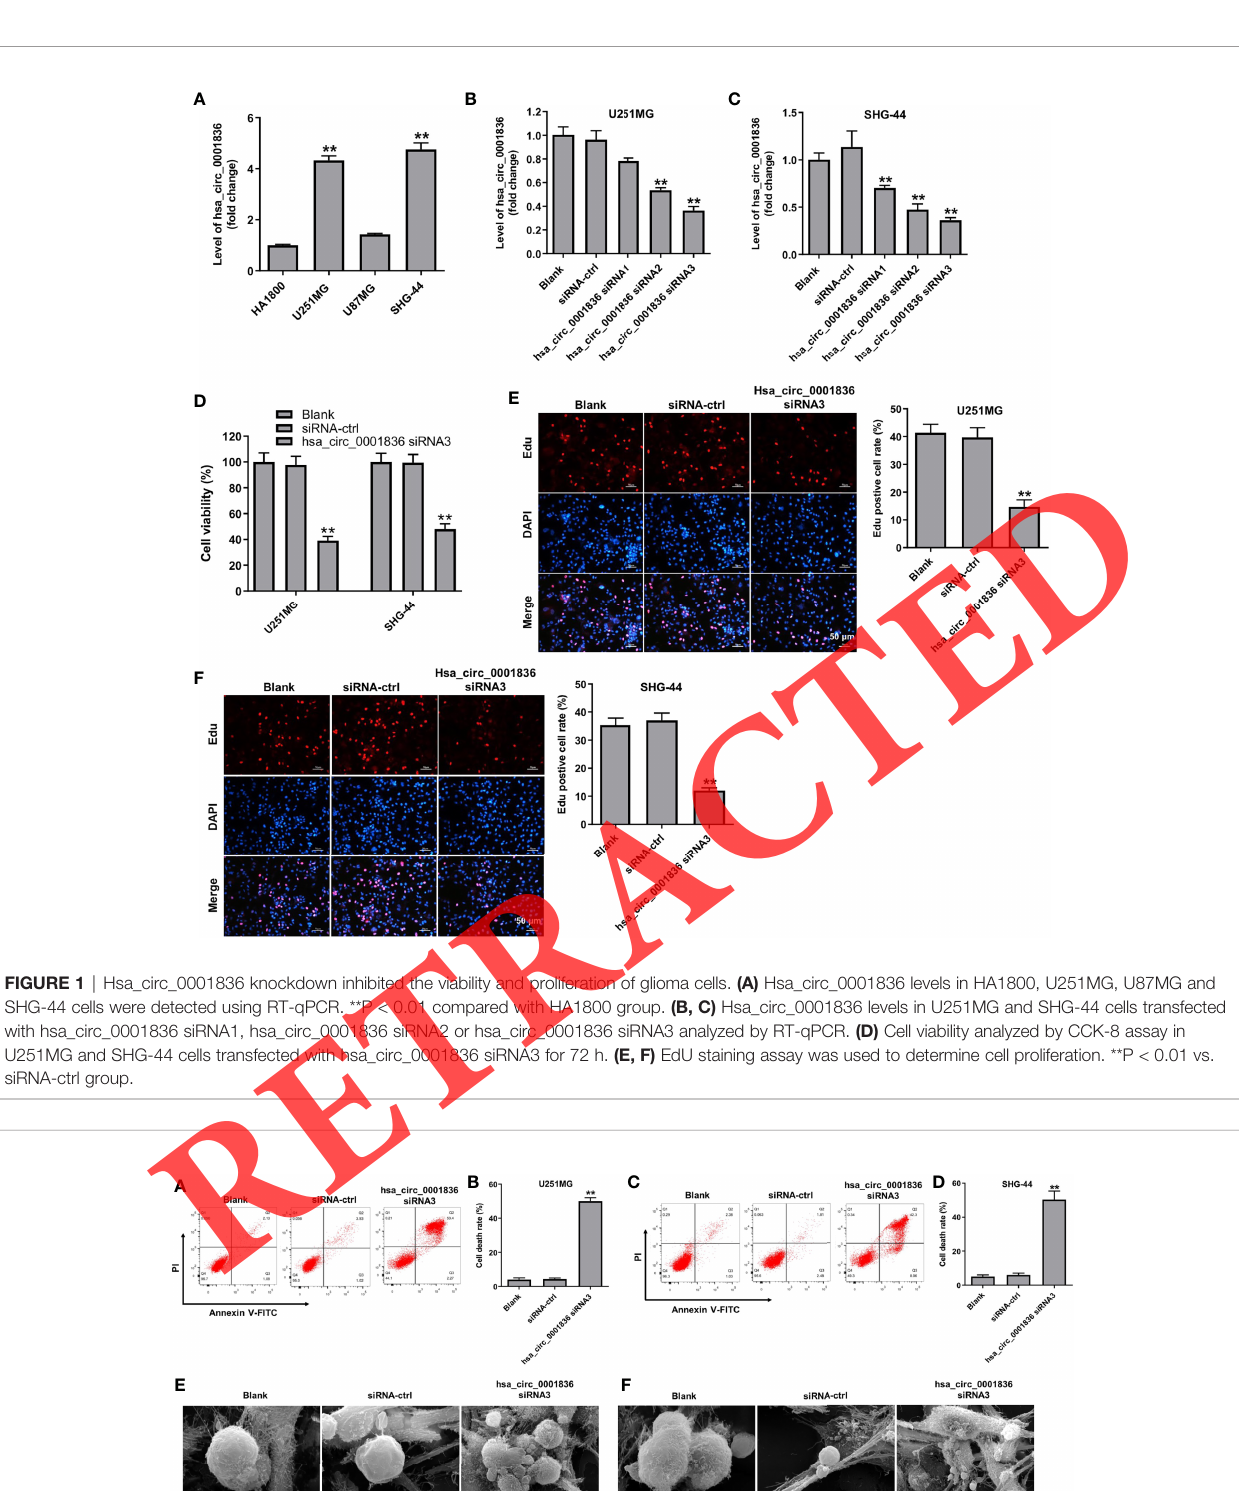
FIGURE 2 | Downregulation of hsa_circ_0001836 induced pyroptosis cell death in glioma cells. U251MG and SHG-44 cells were transfected with hsa_circ_0001836 siRNA3 for 72 h. (A – D) Flow cytometry was used to determine cell death. (E, F) Dying cells revealed by SEM. **P < 0.01 vs. siRNA-ctrl group.